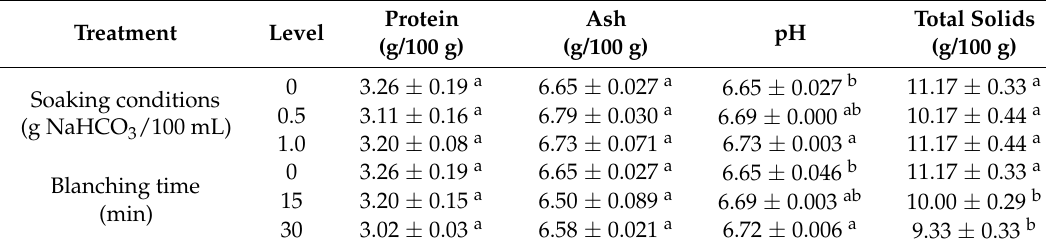
Table 1. Chemical properties of millet milk influenced by production